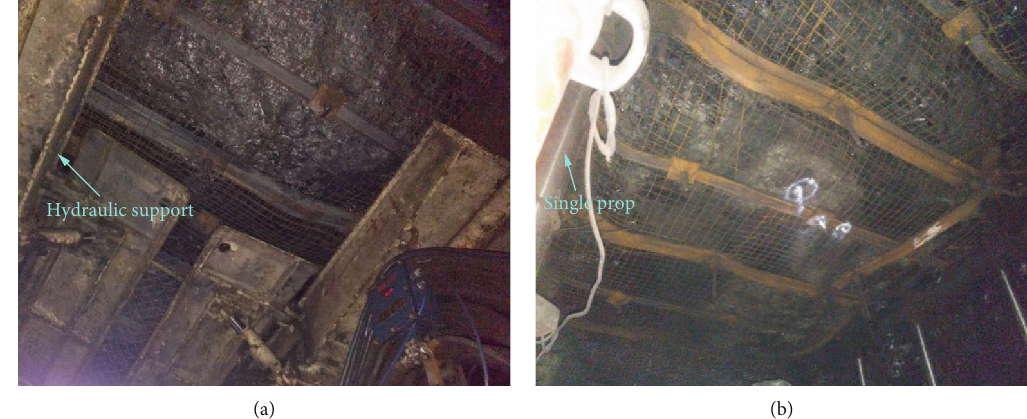
Figure 14: Roadway support with optimized parameters: (a) 20m in front of the workface; (b) 35 m in front of the